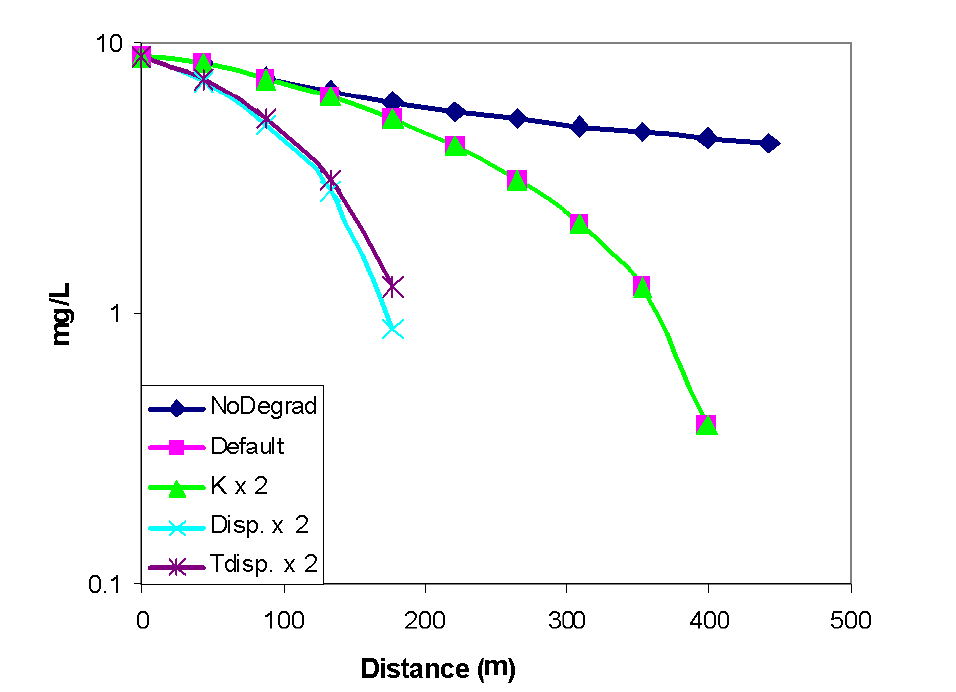
FIGURE 2. Tests of BIOSCREEN reply to variations of hydrodynamic characteristics of the aquifer. Default conditions: K = 8 10 -5 m/s, i = 0.048, ω = 0.25, α L = 8.7 m, α T = α L /10, EA: O 2 = 7.5 mg/l. NoDegrad : absence of biodegradation, Disp.: dispersivity and T: